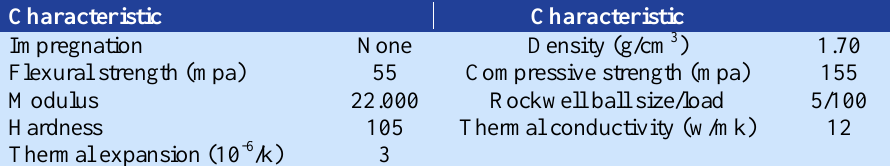
Table 1. The characterization of graphite